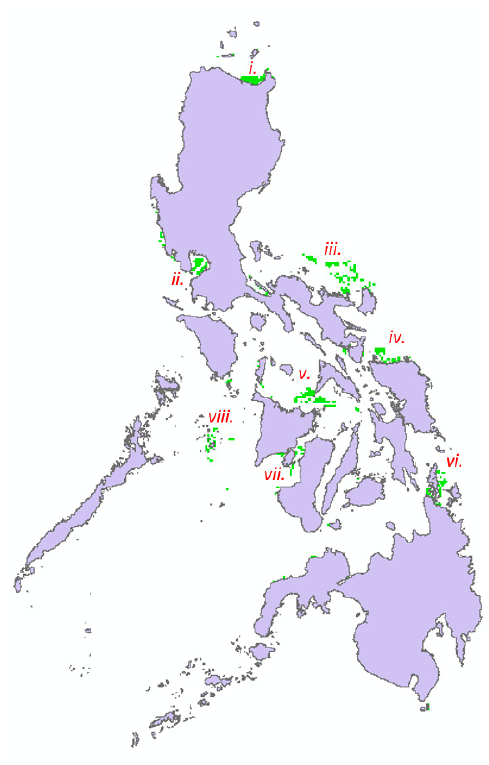
Figure 23. Offshore wind farms sites for SWT-3.6-120.